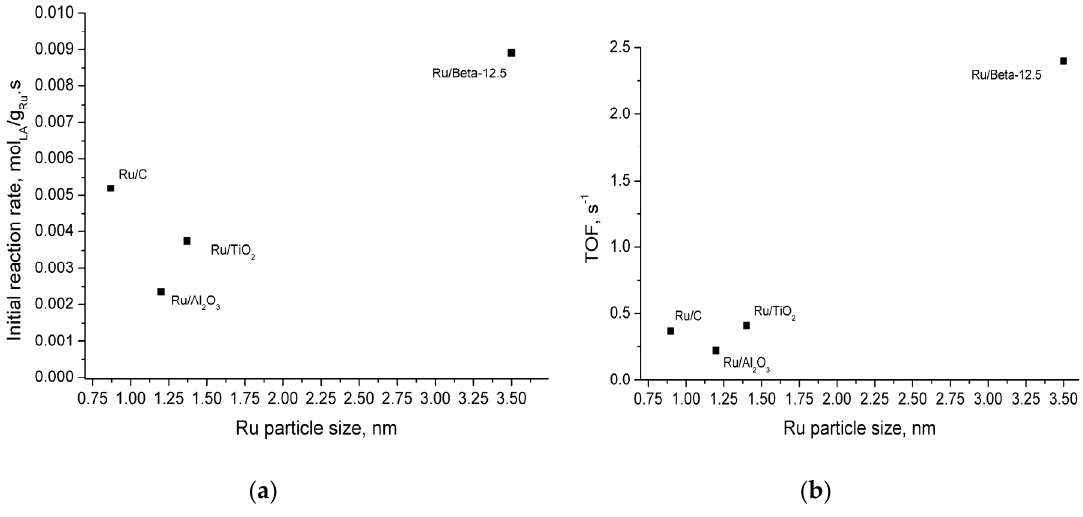
Figure 6. Initial reaction rates and TOF (turnover frequency) values versus Ru particle size for LA hydrogenations using supported Ru catalysts. ( a ) Initial reaction rate, ( b ) TOF.